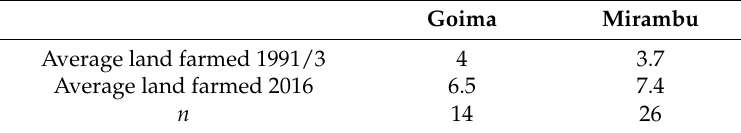
Table 4. Land farmed (acres) in Goima and Mirambu villages